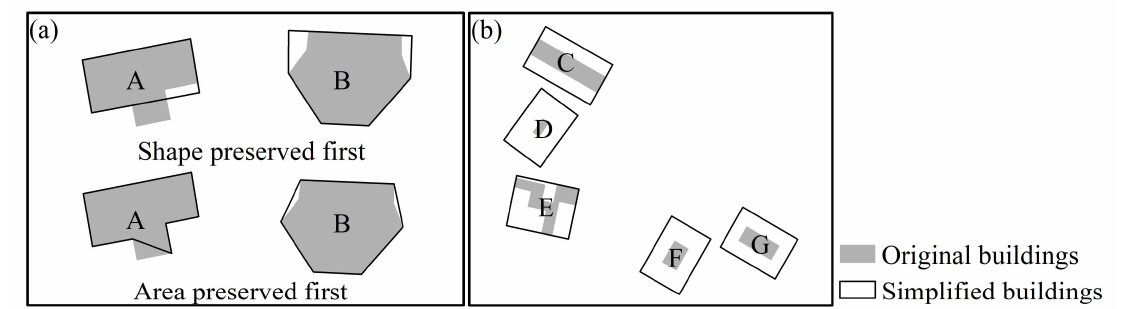
Figure 12. Limitations. ( a ) Buildings A and B are simplified with higher priority separately in shape-preservation and area-preservation constraints; ( b ) Buildings C, D, E or buildings F, G may become too close to be distinguished after simplification with a large reduction in